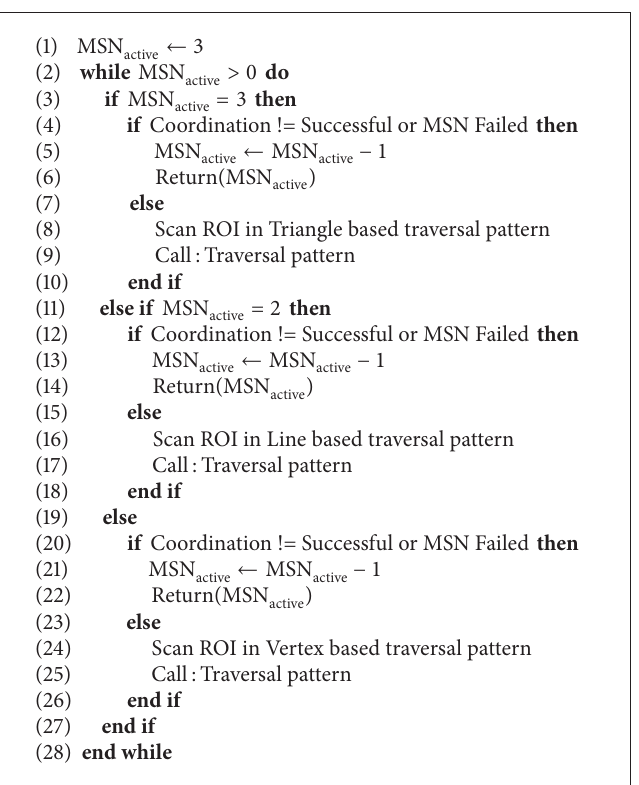
Algorithm 1: Multiple mobile traversal algorithm.